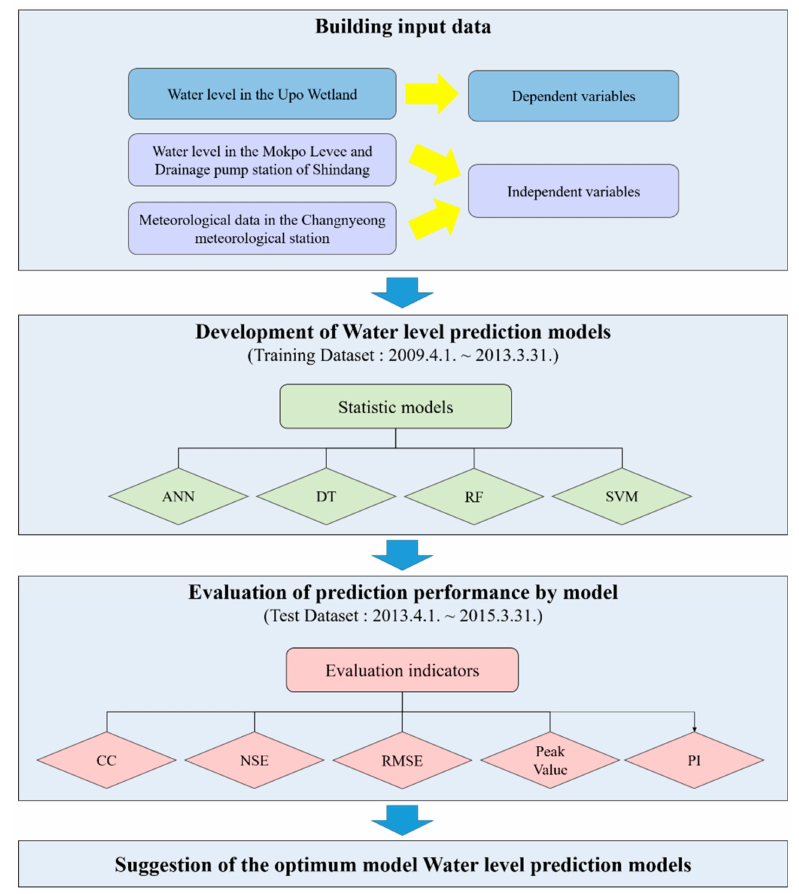
Figure 1. Flow chart of this